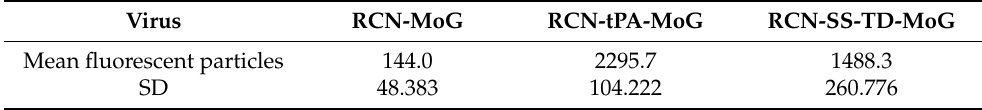
Table 1. Mean of fluorescent particles expressing MoG (with standard deviation), counted from images of immunofluorescence assays. RCN-tPA-MoG has the highest mean, followed by RCN-SS- TD-MoG and RCN-MoG; a significant difference was detected between the three viruses ( p = 0.004).